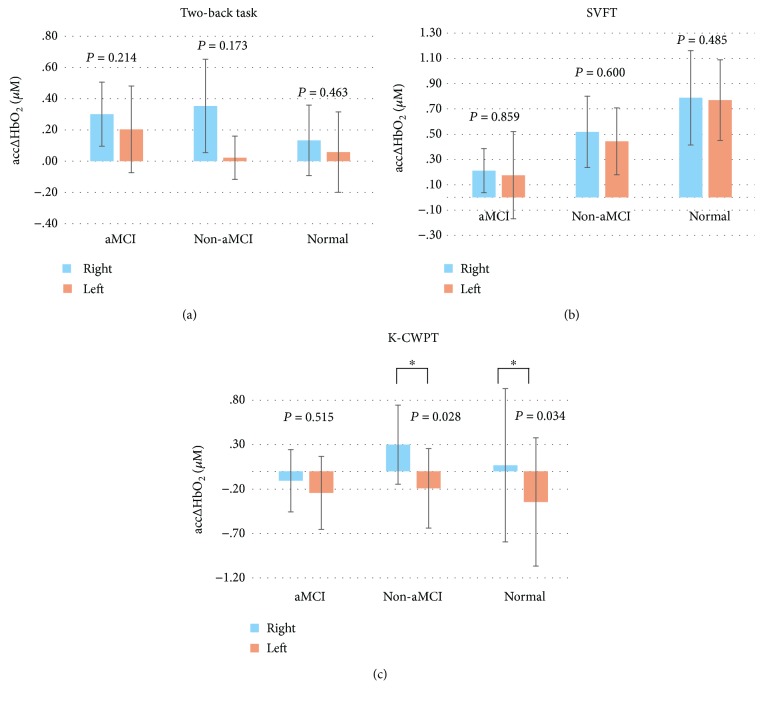
Mean acc∆HbO2 of bilateral prefrontal regions during the tasks in the three groups.